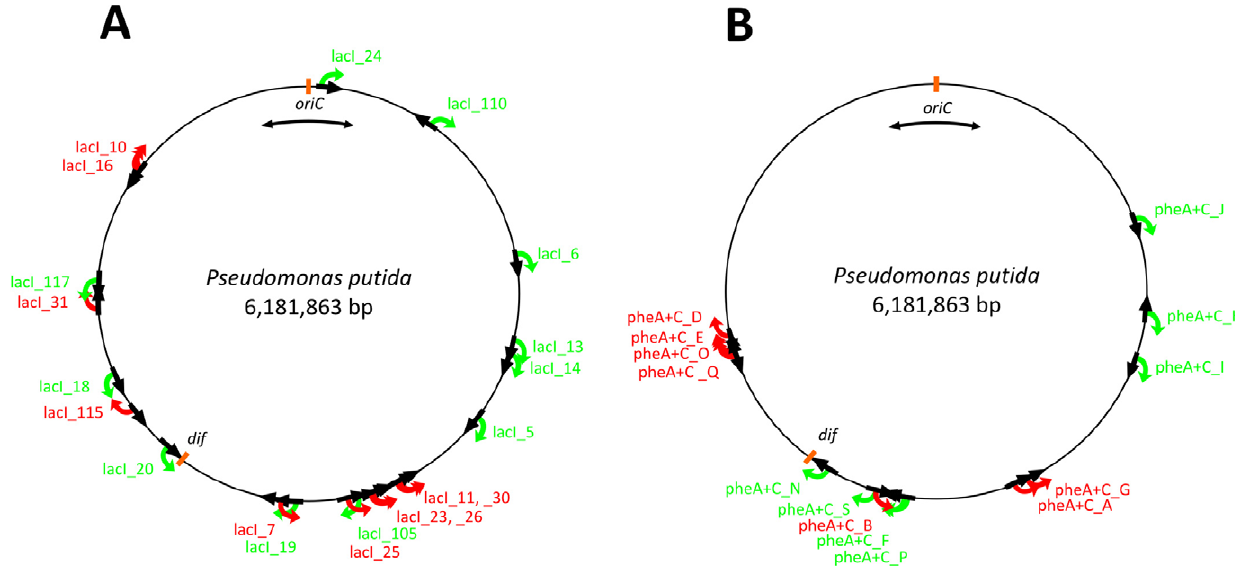
Figure 1. Chromosomal location of the randomly inserted test system in various P.putida strains. The locations of the phe-lacI test system detecting mutations which inactivate LacI repressor are shown in panel A (designated as lacI) and the locations of the pheA + C test system detecting only frameshift mutations are shown in panel B. The black arrows demonstrate the direction of transcription of the P. putida chromosomal genes containing the insertions of the test system. When the transcribed strand is the leading strand template for replication, the RNA polymerase and the replisome move in the same direction (co-directional orientation); when the transcribed strand is the lagging strand template, the RNA polymerase and the replisome converge (head-on orientations). The direction of transcription of the mutational target genes (the lacI gene in the phe-lacI test system and the pheA gene in the pheA + C test system) in different P. putida strains is indicated by green or red arrows. The red arrows designate head-on orientations of the transcription of the mutational target gene and the movement of the replisome in the chromosome and the green arrows point to co-directional transcription and replication. The replication of the chromosome starts at oriC region (indicated by two- directional arrow) and terminates at dif sites. Location of P. putida dif sequence is according to [87].